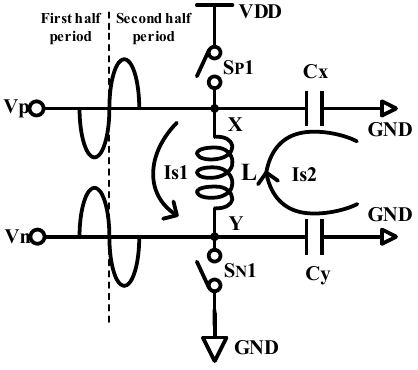
Figure 5. Behavior model of current-reuse VCO.